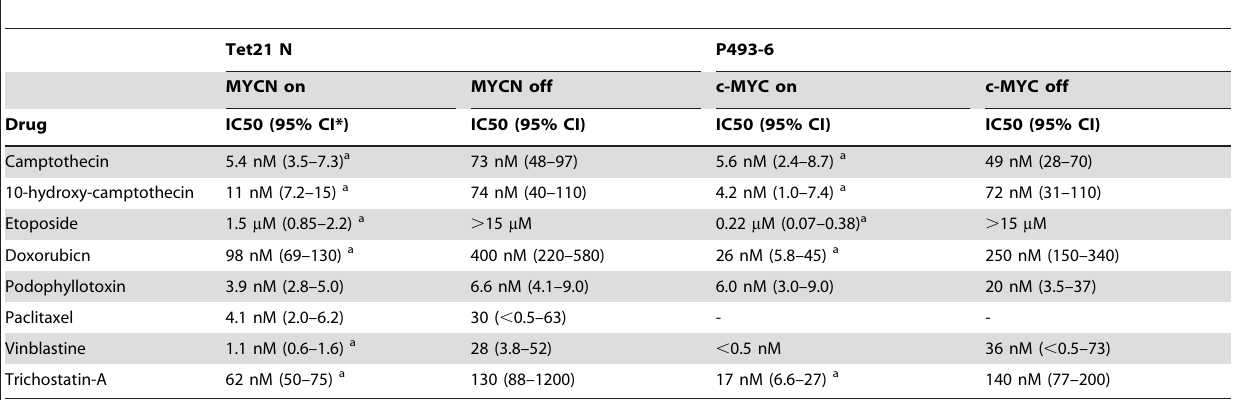
Table 2. IC50 values in cells with low versus high MYC-expression